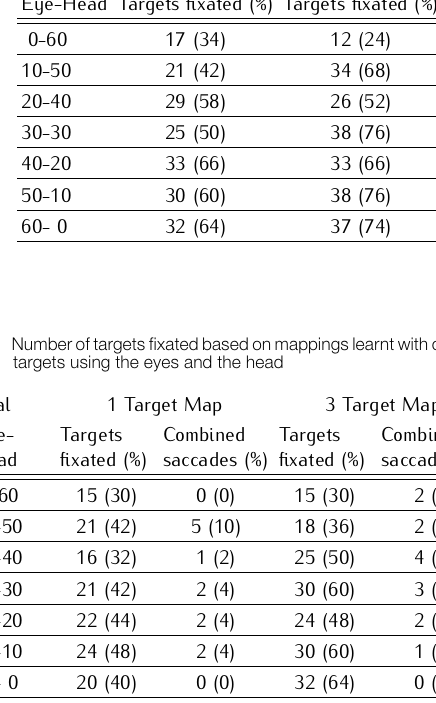
Table 1. Numberoftargetsfixatedbasedonmappingslearntwithoneandthree targets using only the eyes